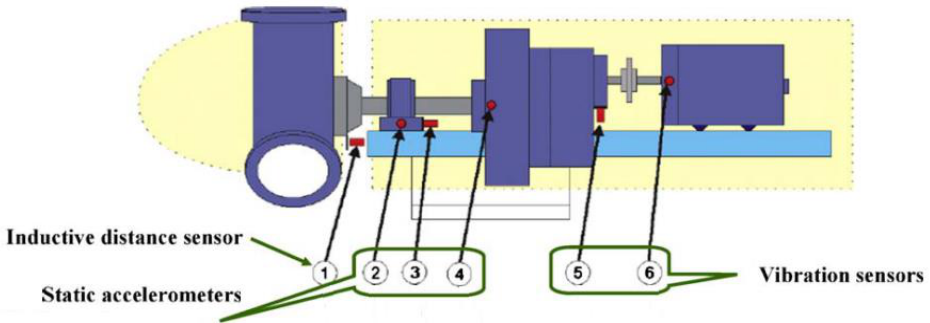
Figure 2. Example of vibration sensor positions on a drivetrain. Reproduced from [24], Elsevier.